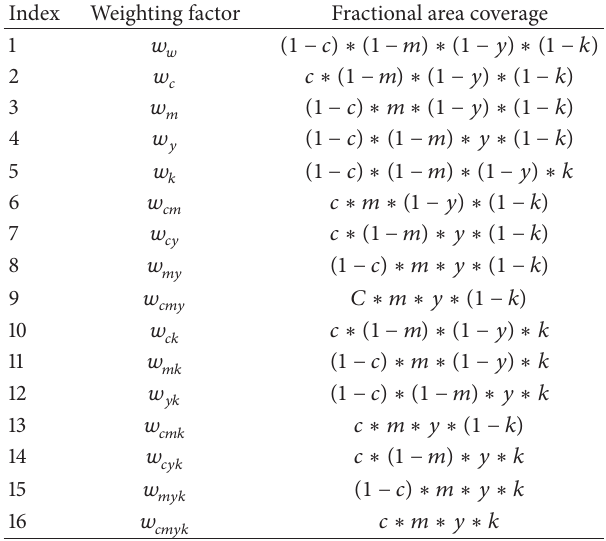
Table 1: The respective fractional area coverages of the CMYK